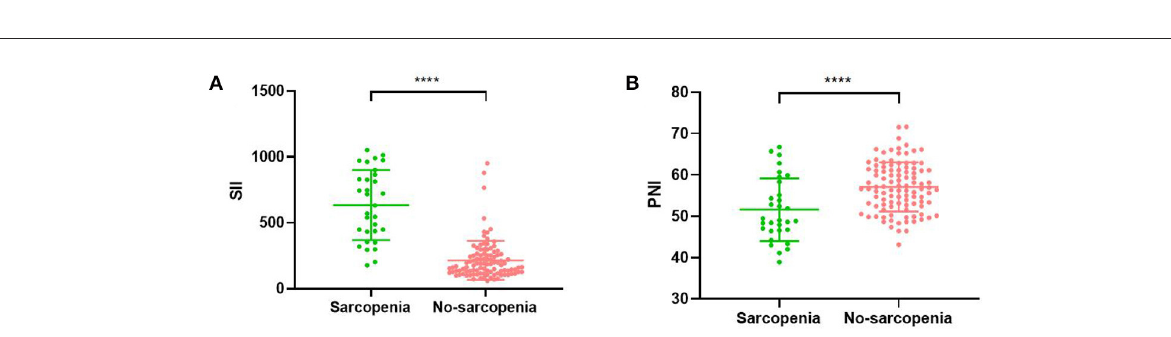
FIGURE4 Relationship between sarcopenia and the SII (A) /PNI (B) . SII, systemic inflammatory immunity index; PNI, prognostic nutritional index; ****<0.001.